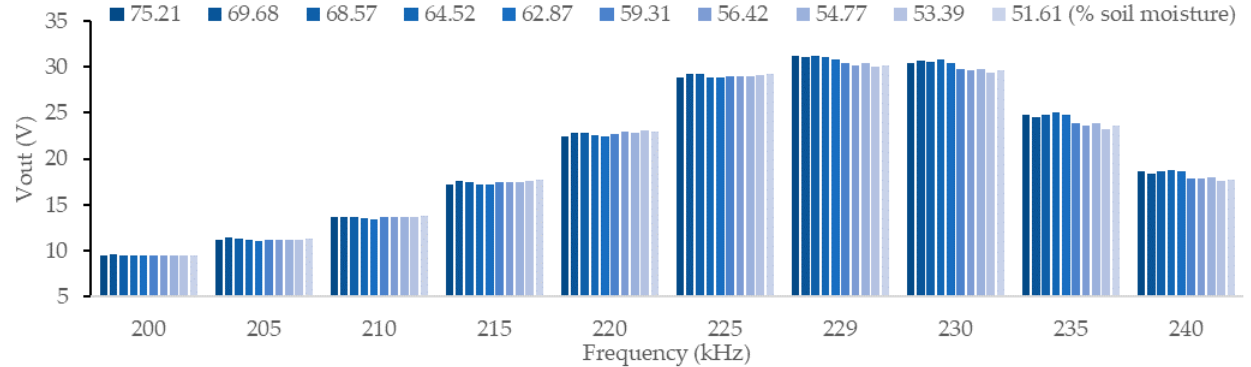
Figure 11. Vout of P5 using S1.